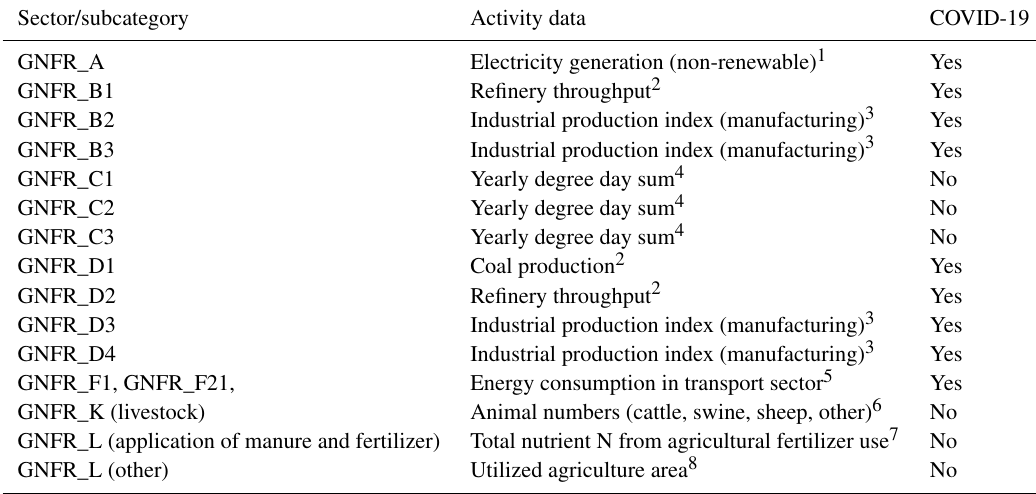
Table 3. Overview of activity data used for each emission sector and subcategory as defined in Tables 1 and 2 to derive the BAU 2020 emissions and expected COVID-19 impact.